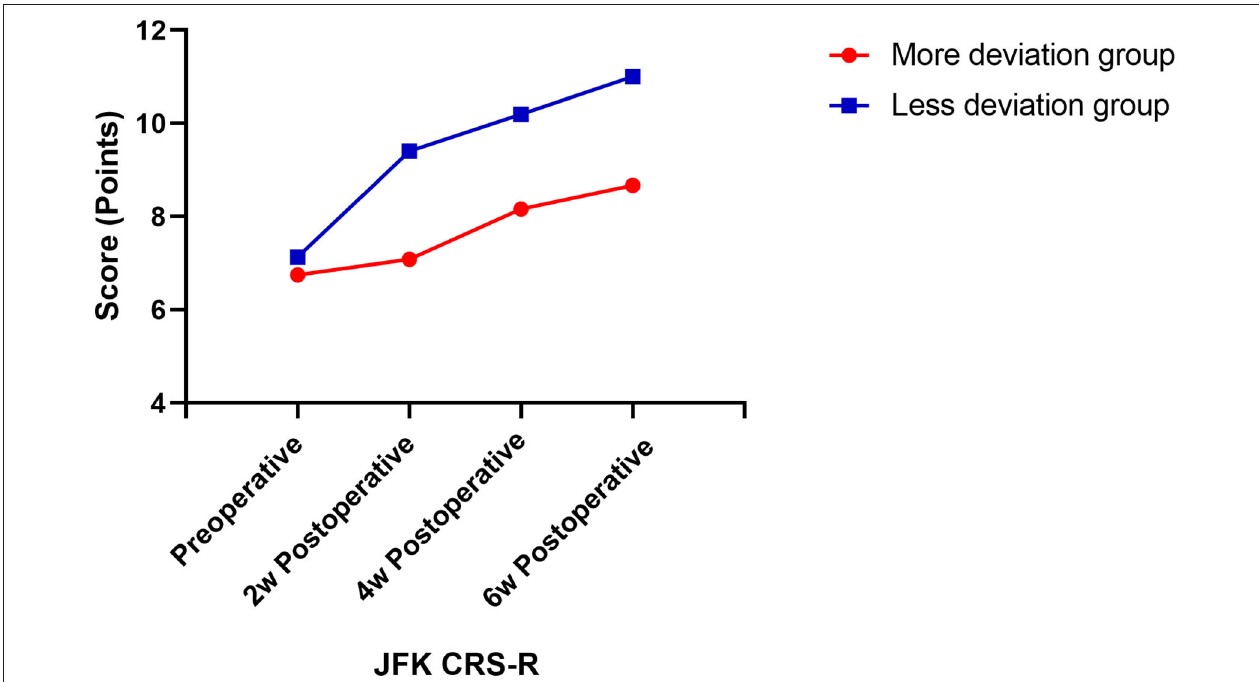
FIGURE 3 | Postoperative CRS-R score change curve. CRS-R scores were assessed at four time-points, which were preoperative, 2 weeks, 4 weeks, and 6 weeks